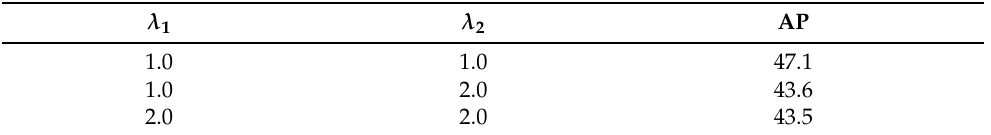
Table 3. Comparison between weights for regression loss and classification loss.